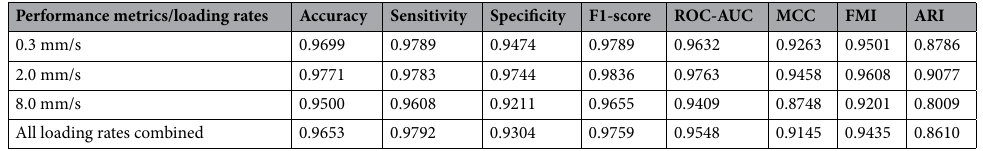
Table 2. Performance metrics of the classifier obtained from leave-one-out cross-validation.